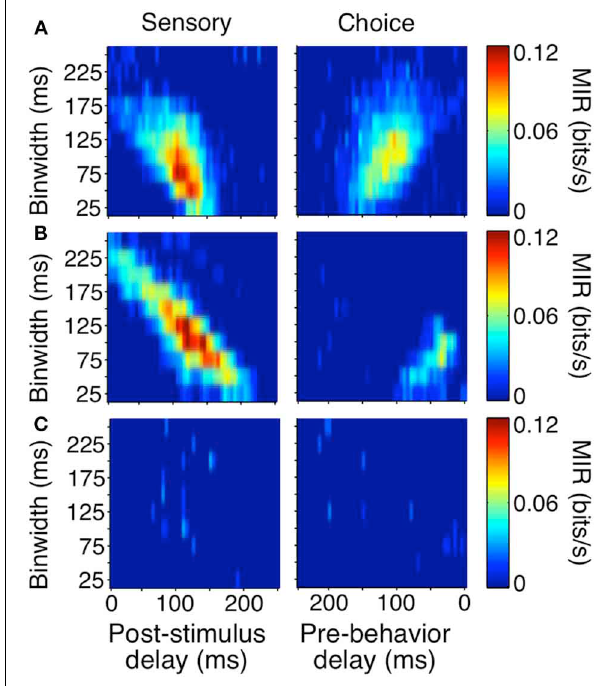
FIGURE 6 | Covariance- and bias-corrected sensory (left columns) and choice (right columns) surfaces corresponding to the example cells in Figure 3. Color represents the magnitude of corrected MIR. The cells in (A,B) were some of the more reliable units about both the stimulus and the animal’s behavior when specific bin separations and widths were used. The cell in (C) is representative of neurons lacking a well-defined peak on either surface. The diagonal appearance of the peak was to be expected if the neuronal response occurs with a consistent delay. As binwidth increased in steps of 25ms, the neuronal response was considered 25ms further into the